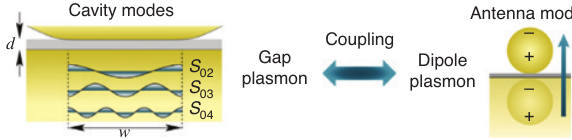
Figure 2: Schematic of the coupling between strongly confined transverse cavity modes (gap plasmon) and the radiative longitudinal antenna mode (dipole plasmon).